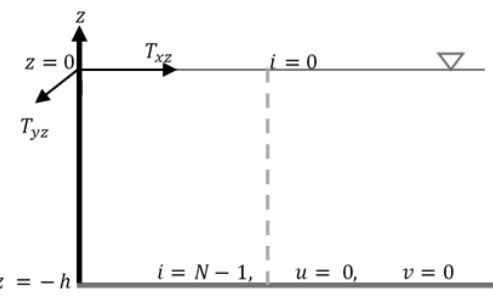
Figure 2. Schematic of the applied system of reference where i represents the i th vertical position to be analyzed. The upper boundary layer is established at z = 0 while the bottom boundary layer is at z = − h .